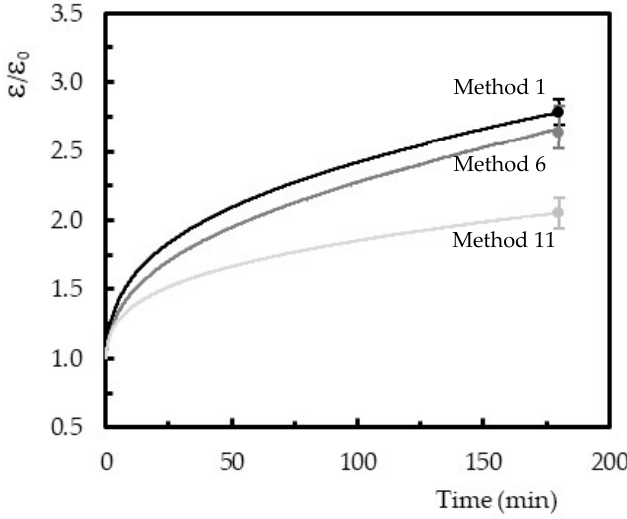
Figure 10. Creep curves obtained for the methods 1, 6, and 11 (bending stress of 20 MPa).